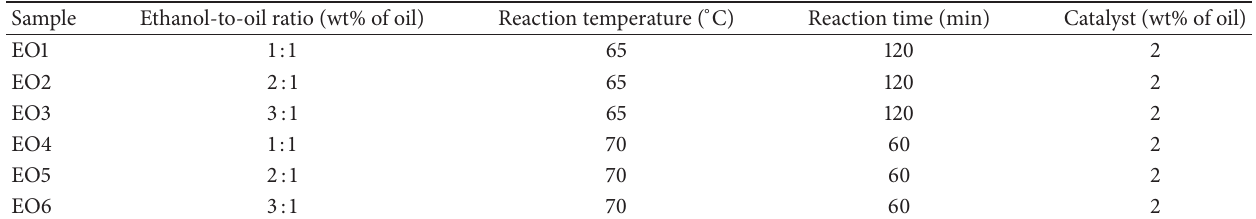
Table 1: Parameter for